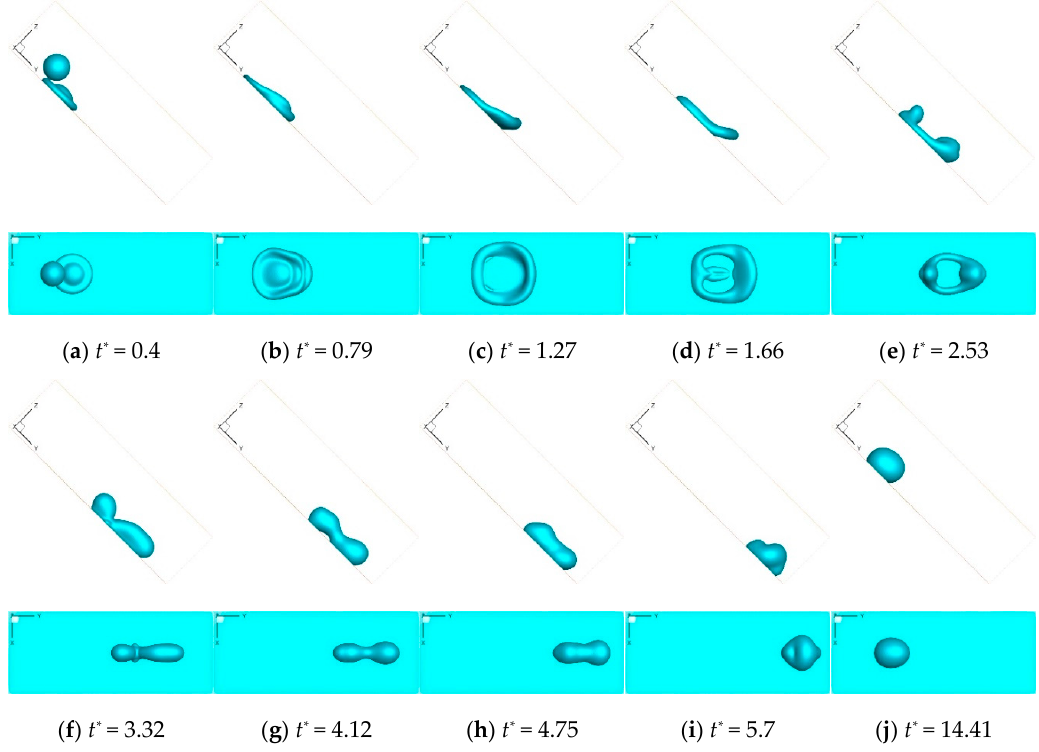
Figure 10. Snapshots of two successive droplets impacting an inclined surface with θ = 140° at v r = 1.5.